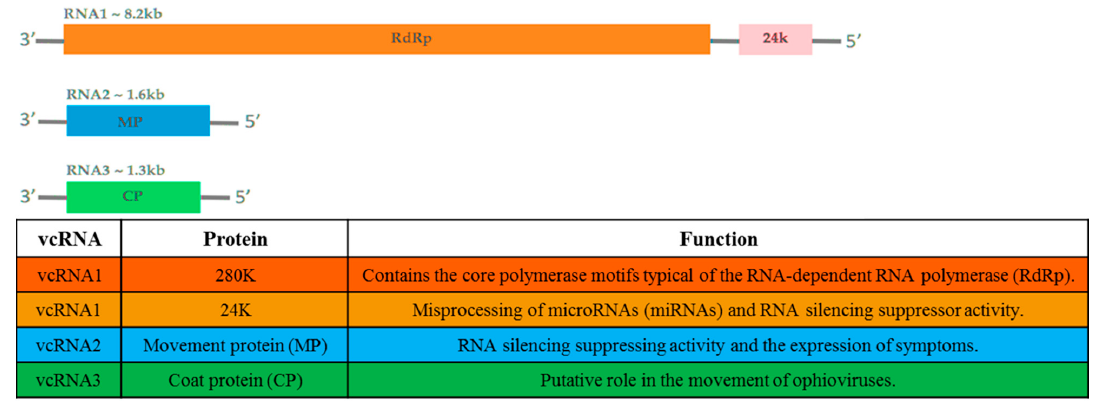
Figure 1. Genomic organization of citrus psorosis virus (upper panel). The three genomic RNAs are represented. Boxes indicate open reading frames (ORFs) with an indication of the encoded proteins (lower panel).